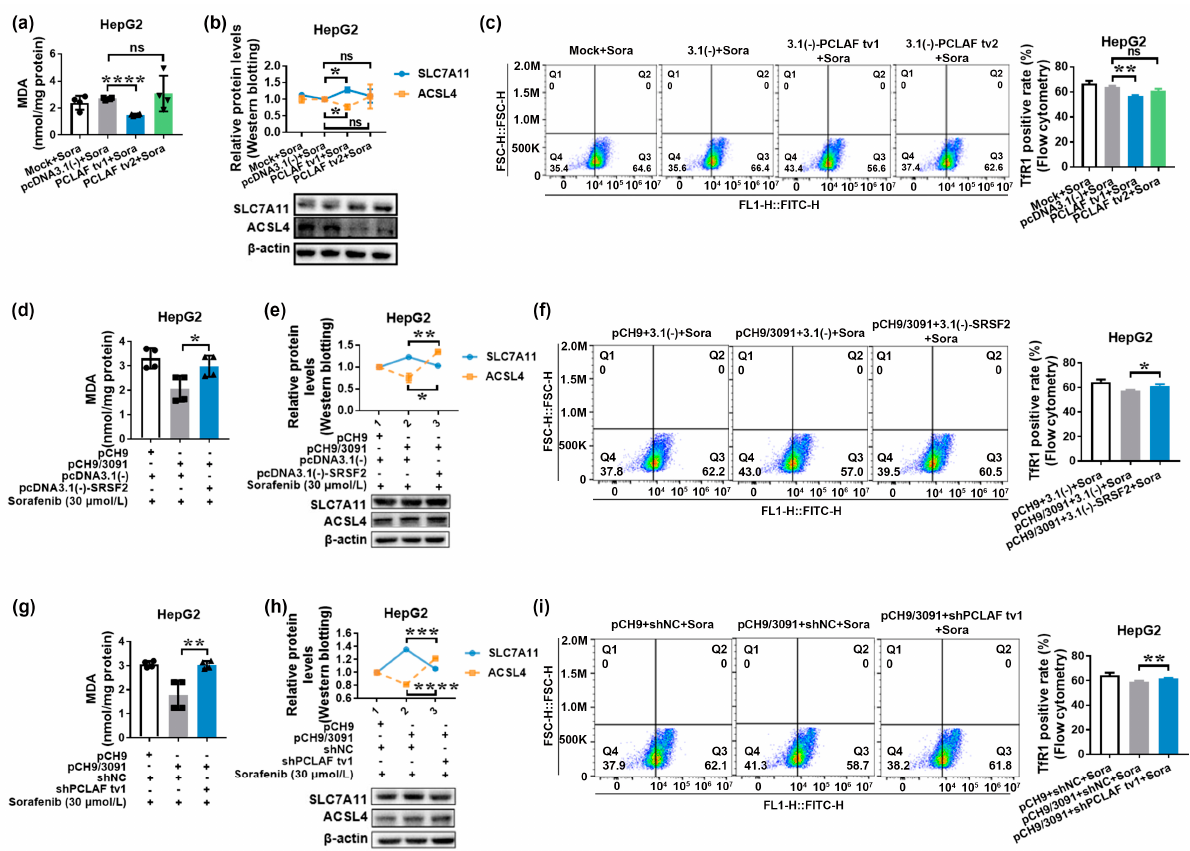
and overexpression of PCLAF tv1 all contribute to inhibition of sorafenib-induced ferrop- tosis.